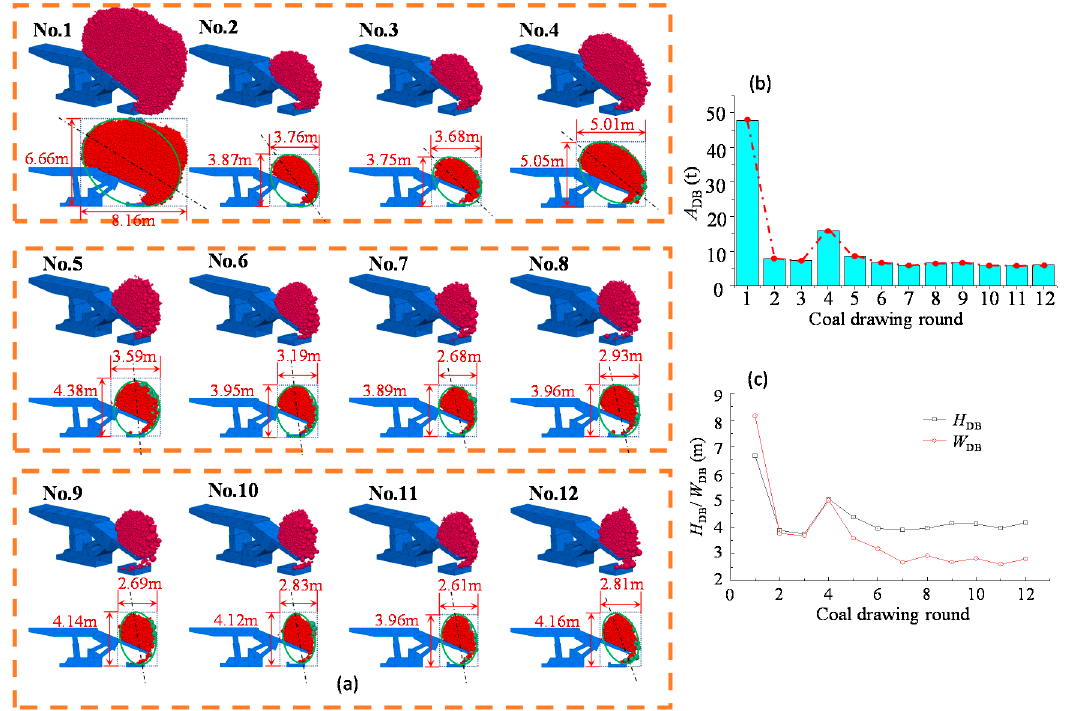
Figure 6. The shape of DB. ( a ) The Shape of DBs; ( b ) Evolution of A DB in the process of coal drawing; ( c ) Evolution of H DB and W DB in the process of coal drawing.